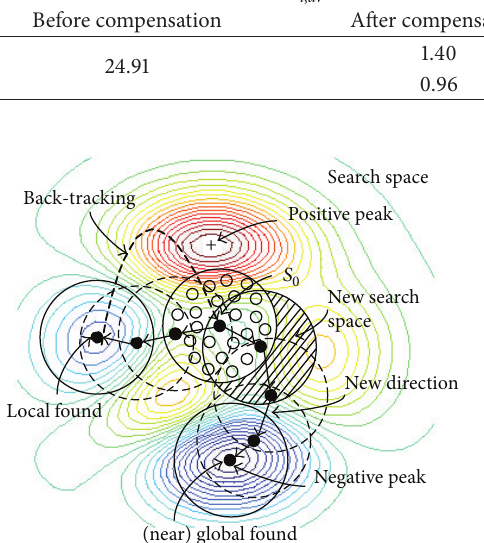
Figure 19: Back-tracking in ATS algorithm.